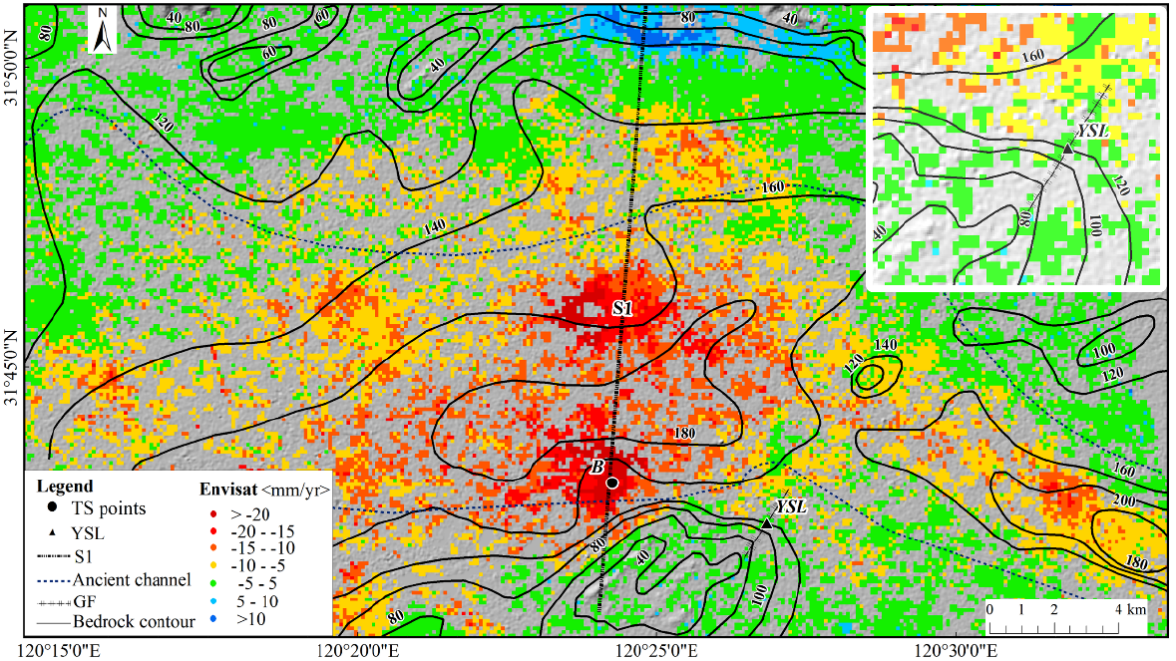
Figure 8. The land subsidence field in southern Jiangyin city (the small figure in the upper right corner is an enlarged view of the ground fissure area).